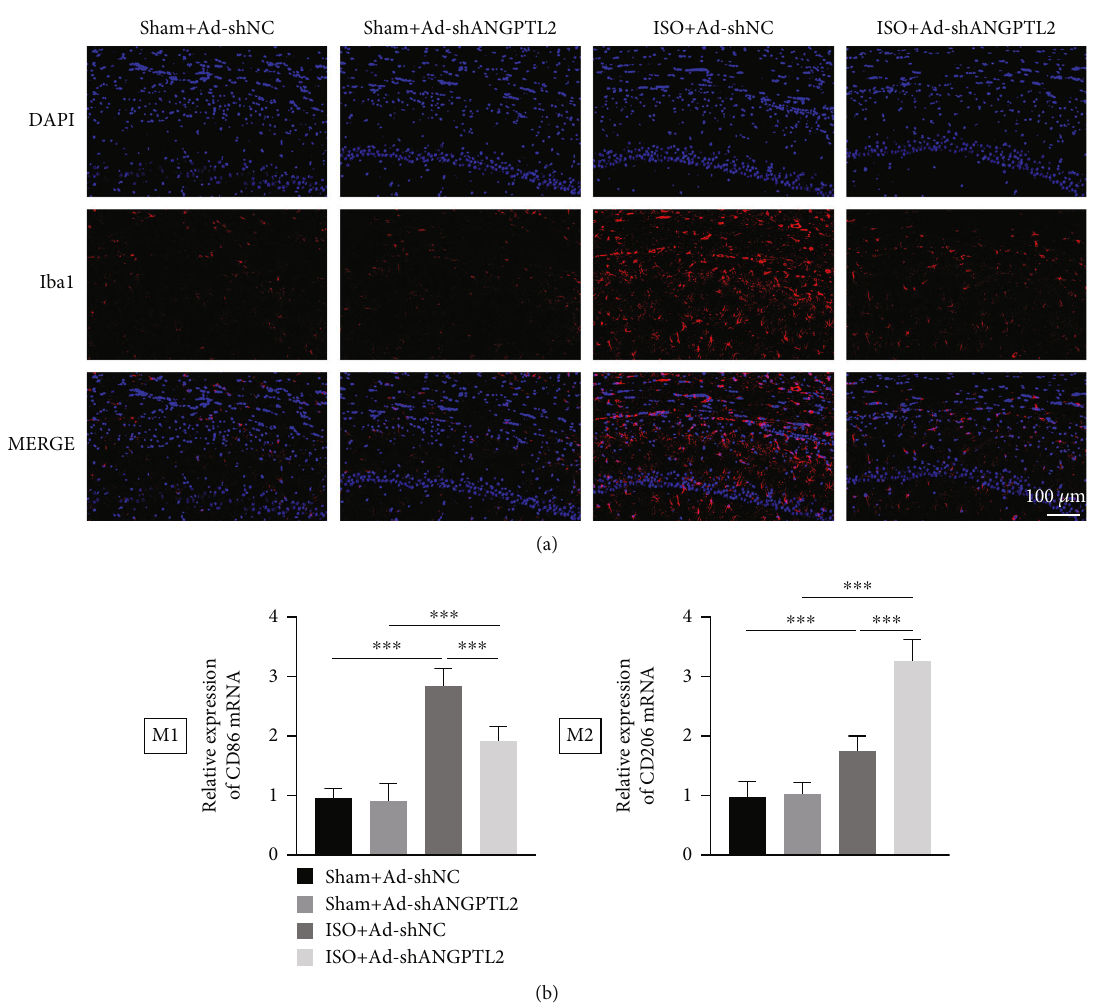
Figure 4: Downregulation of ANGPTL2 decreased iso fl urane-induced microglial activation in brain tissues of mice. (a) Immuno fl uorescence was conducted to examine Iba1 expression. (b) CD86 and CD206 mRNA levels were detected through qRT-PCR. n = 6 . ∗∗∗ p < 0 : 001